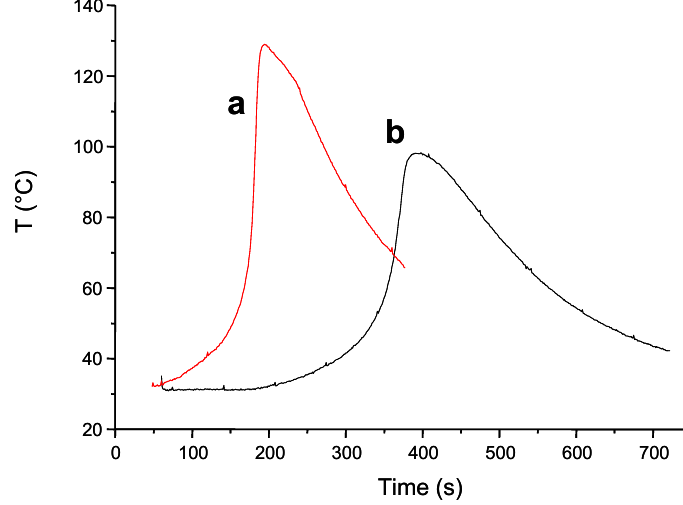
Figure 5. Polymerization process of an acrylate matrix (Ebecryl 605 from Cytec) initiated at RT under air for different initiating systems: ( a ) Cumene hydroperoxide/Cobalt (II) salt/(TMS) SiH; ( b ) Cumene hydroperoxide/Cobalt (II) 3